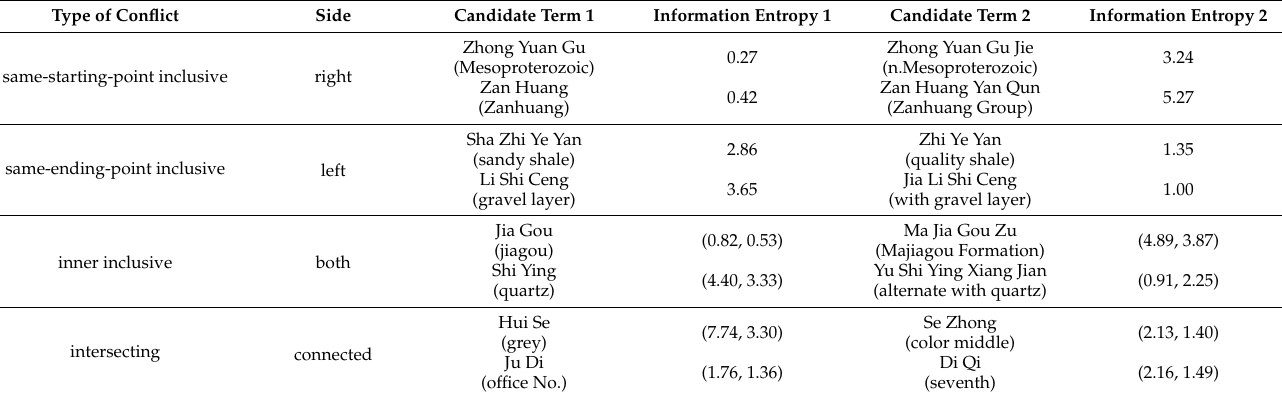
Table 1. High-degree-of-freedom priority strategy based on information entropy.